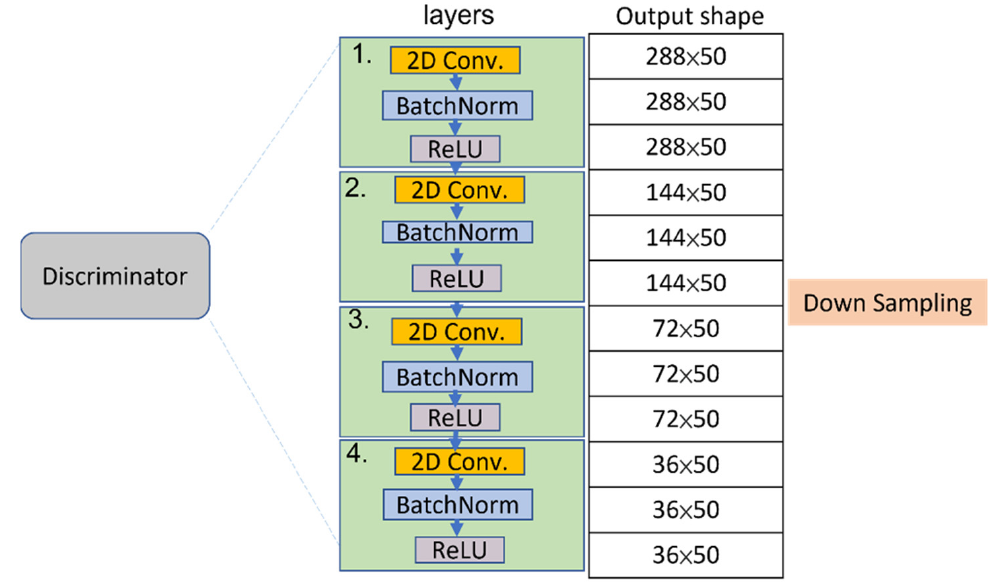
Figure 7. The block diagram of the discriminator.